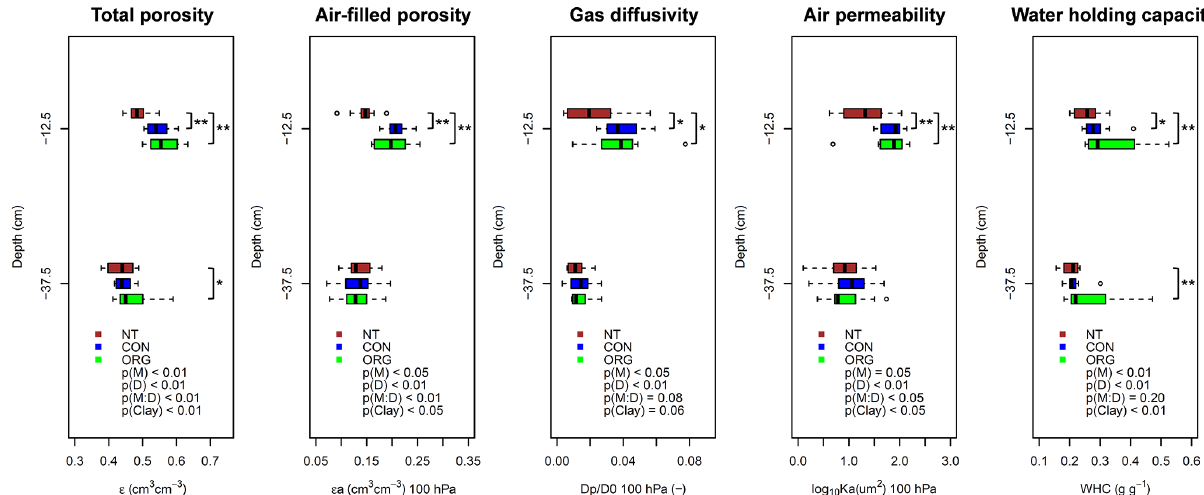
Figure 2. Effects of soil management ( M ), sampling depth ( D ), their interaction ( M : D ), and clay content (Clay) on total soil porosity, air-filled porosity, gas diffusivity, and air permeability (all measured at 100hPa matric suction) and water holding capacity, analysed with linear mixed models (Eq. 2) followed by analysis of covariance. NT (red), CON (blue), and ORG (green) denote the no-till, conventional, and organic management system, respectively. ∗∗ and ∗ indicate significant differences between management systems at individual depths using least significant difference (LSD) tests at p< 0 . 01 and p< 0 . 05, respectively ( n =